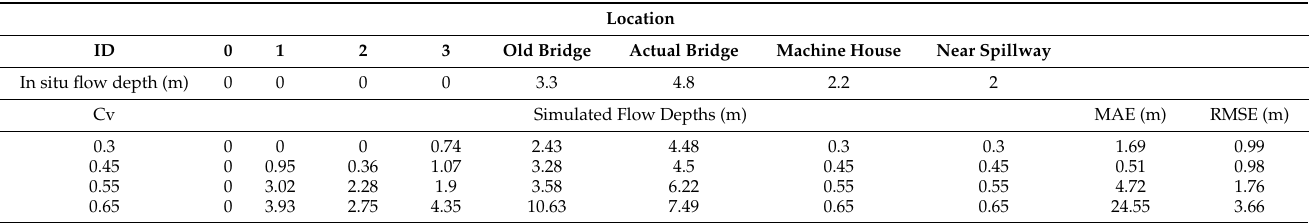
Table 5. In situ depths compared to FLO-2D flow depths.